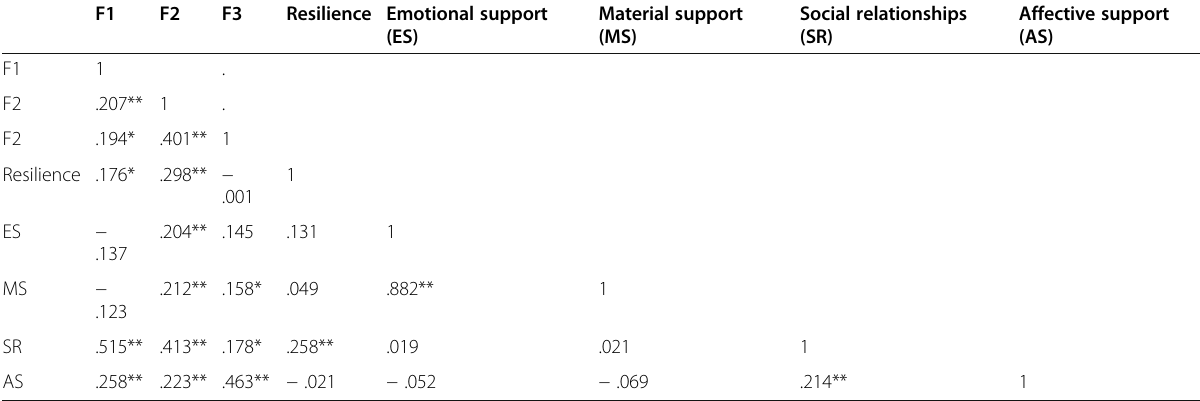
Table 3 Pearson coefficients among Factors and construct validity ( n =228) F3